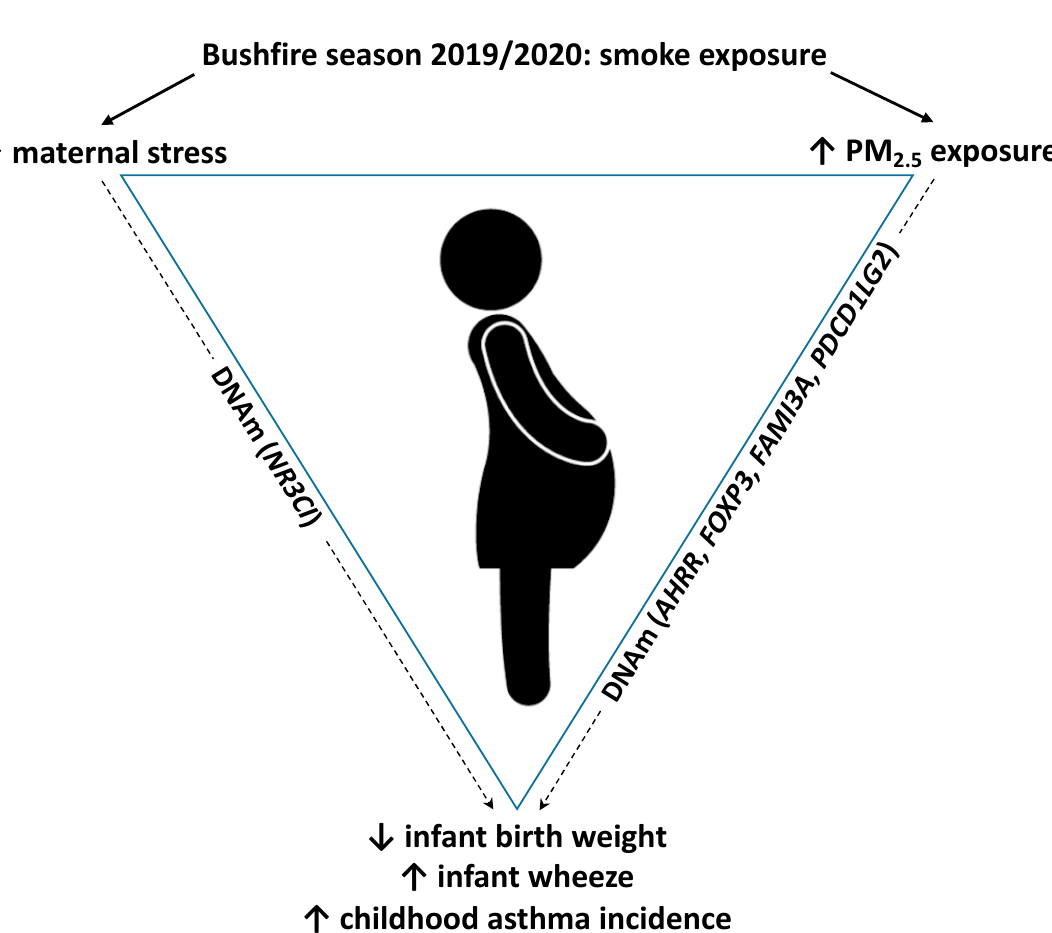
Figure 1. Proposed associations between exposure to stress and PM2.5 during the bushfire season, and adverse infant outcomes, mediated by epigenetic mechanisms.